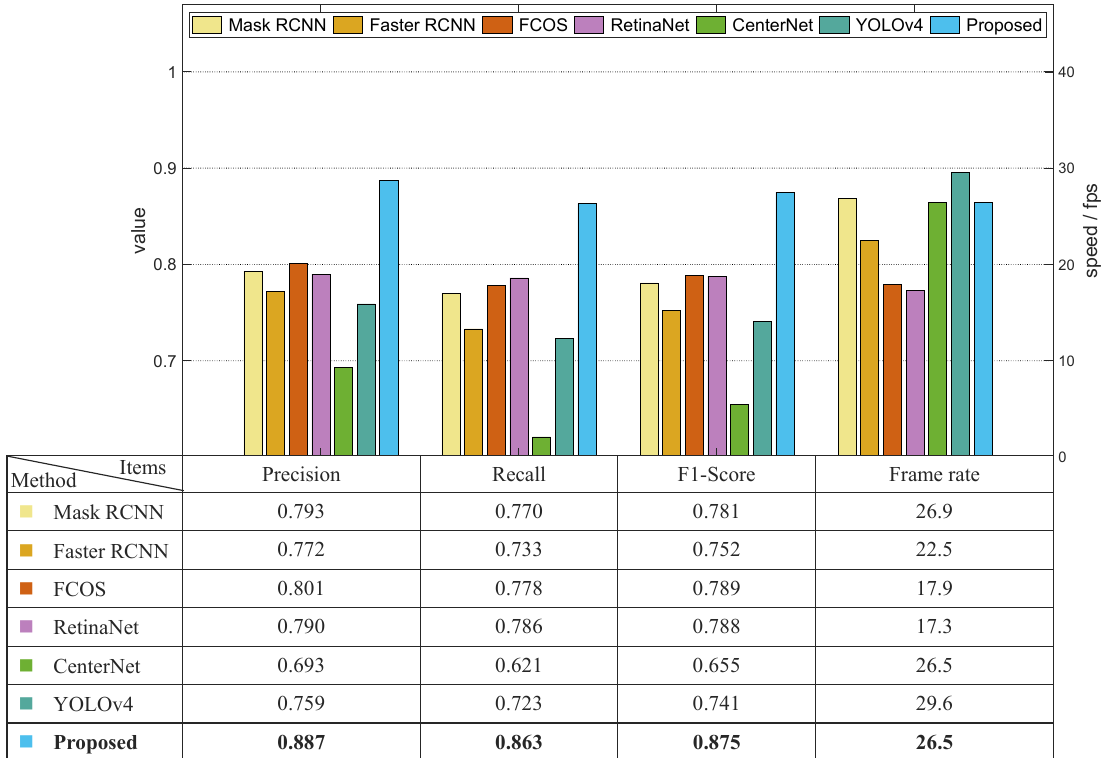
Figure 10. Results of comparison experiment using dataset O.